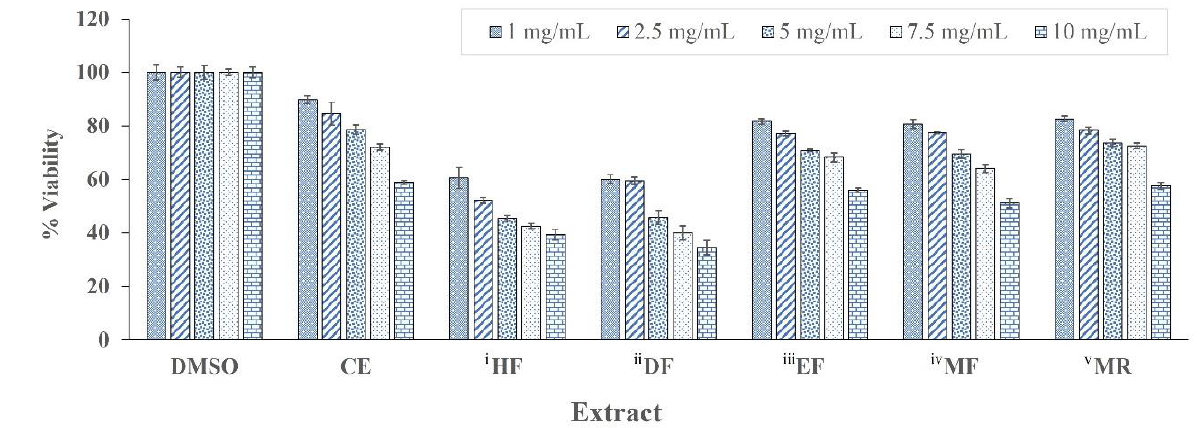
Figure 11. Cell viability study of E. debile extracts on skin fibroblast cell line (SF-TY) using MTT assay. i–v Successive partition of crude extract (CE) (10.45 ± 1.20 g) into hexane fraction (HF), dichloromethane fraction (DF), ethyl acetate fraction (EF), methanol fraction (MF), and methanol insoluble residue (MR). All data are presented as mean ± SD of triplicates.